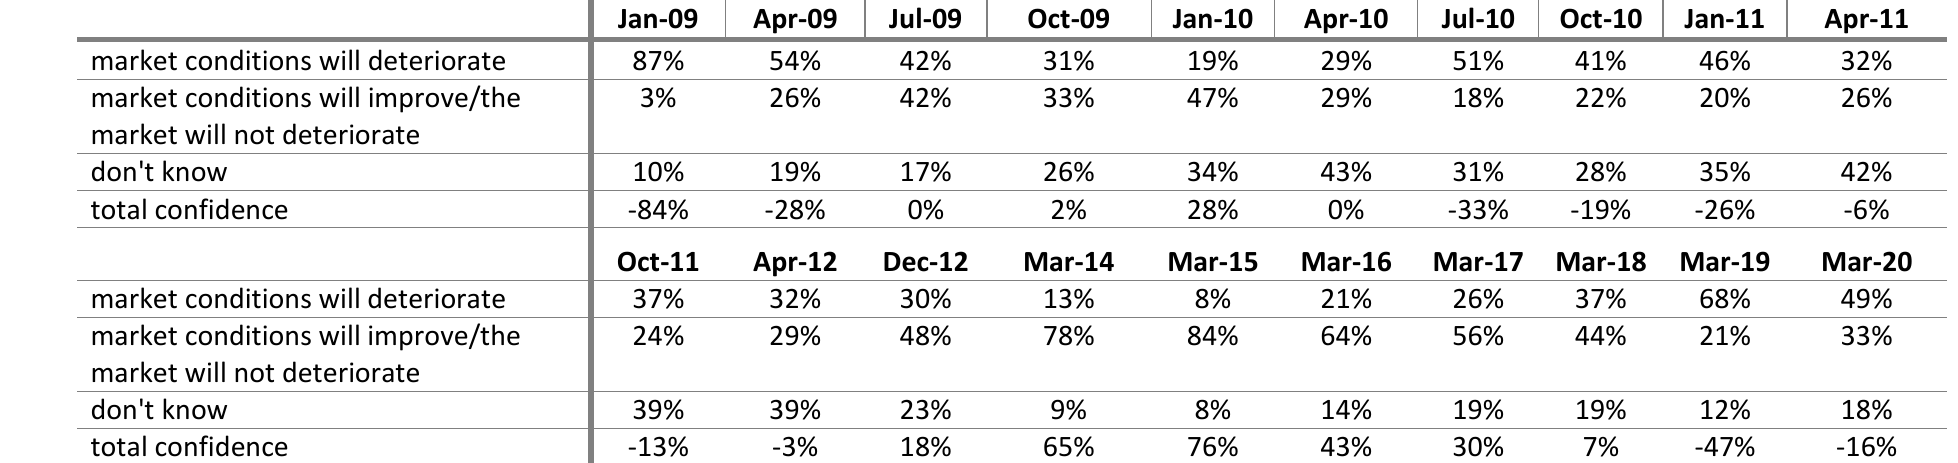
Table 19: Market confidence levels from January 2009 to March 2020 . Total confidence is those that think the market won’t deteriorate minus those that